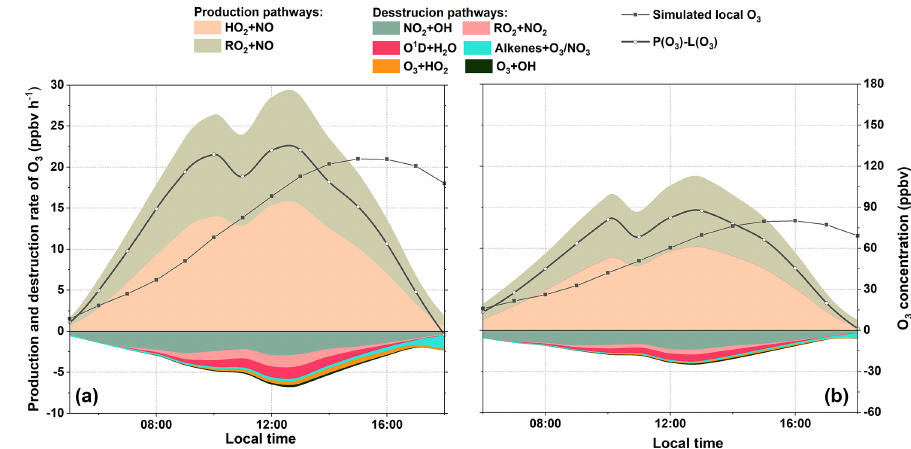
Figure 7. Simulated average diurnal profiles of O 3 formation and sink rates (ppbvh − 1 ) in S0 (a) and S1 (b) .